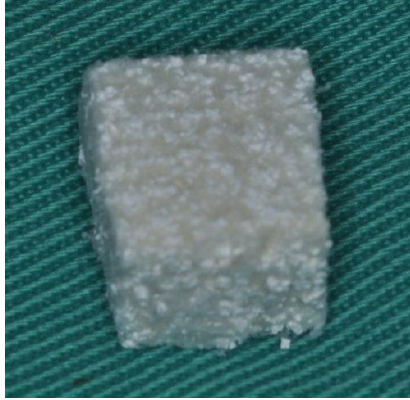
Figure 10. Hydroxyapatite/β-tricalcium phosphate-collagen composite.